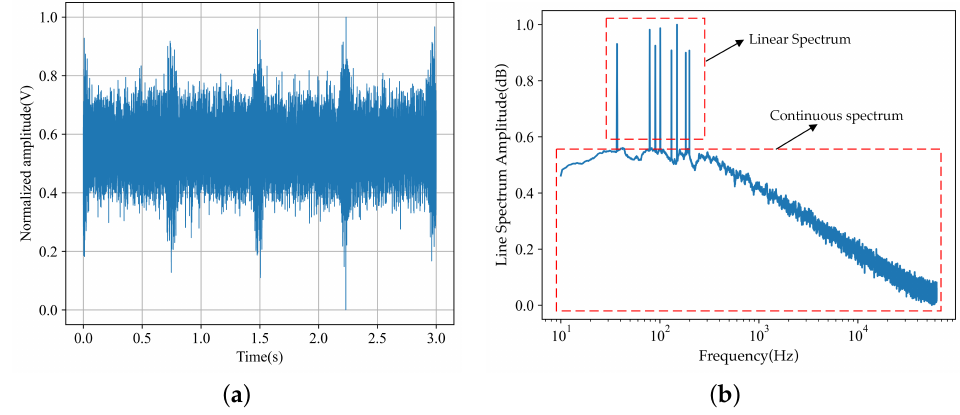
Figure 15. Visualization results of the time-domain and frequency spectrum of VURN: ( a ) the time-domain visualization results of VURN; ( b ) the spectral characteristics of